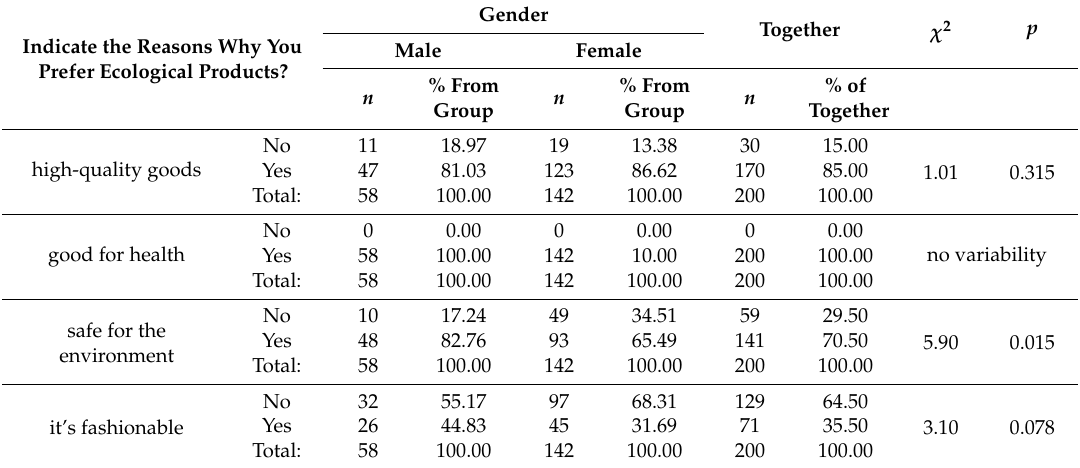
Table 5. Gender vs. the indication of preferences for ecological goods— χ 2 independence